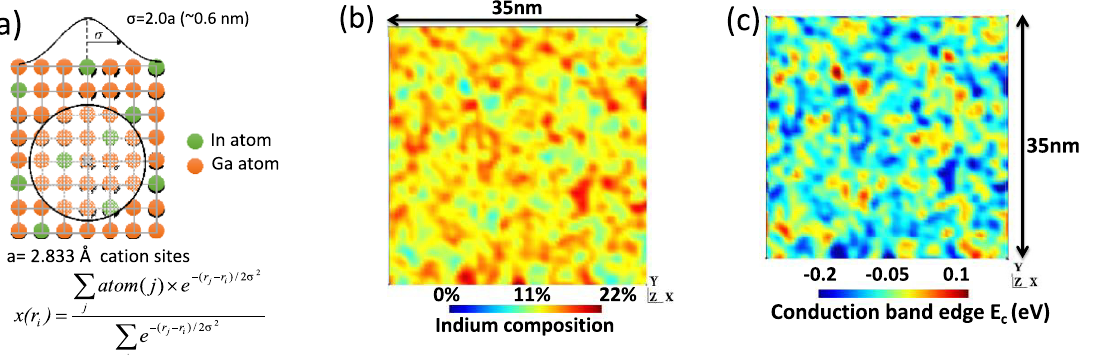
Figure 7: Construction of the potential map seen by electrons; (a) Gaussian averaging of In composition; (b) resulting compositional map in themiddleofanIn 0,14 Ga 0.86 NQW;(c)potentialmapofconductionelectrons.Energycountedfromthebottomoftheband(fromthestudybyLi et al. [14]).